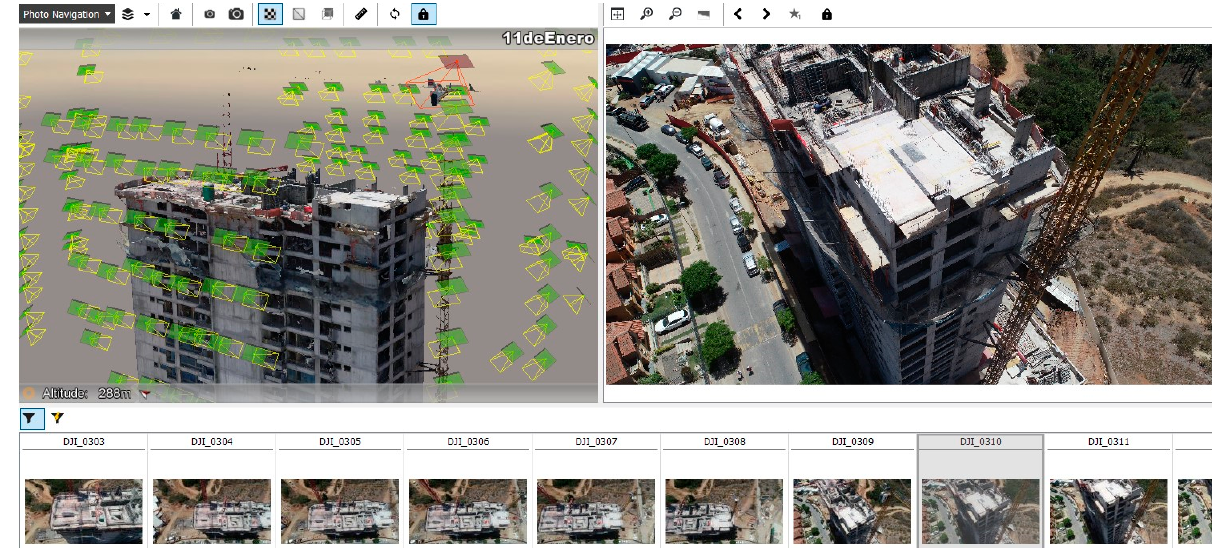
Figure 7. Pose of each photograph rectified by aerotriangulation.